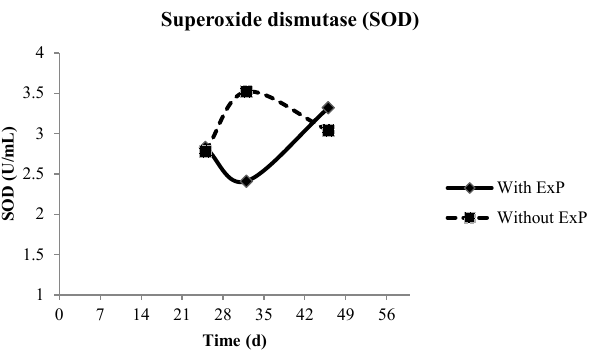
Figure 1. Glutathione-peroxidase activity in plasma of Dorper×Santa Ines lambs receiving a high-concentrate diet with different antioxidant additives at first and second sampling.